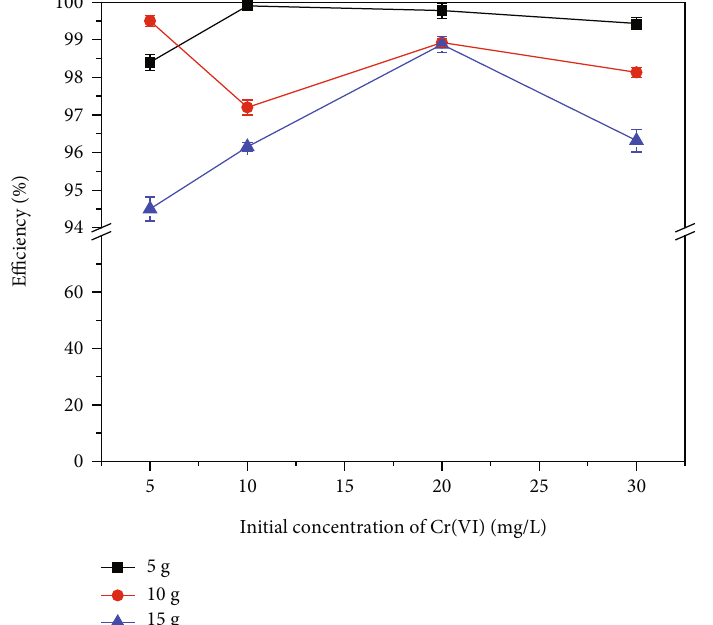
Figure 3: E ff ect of initial concentration on percentage removal of Cr 6+ by SSAC ( Co = 30mg/L , 20 mg/L, 10mg/L, and 5mg/L; adsorbent dose 5 g, 10g, and 15g; agitation speed = 120 rpm ; time = 180 minutes